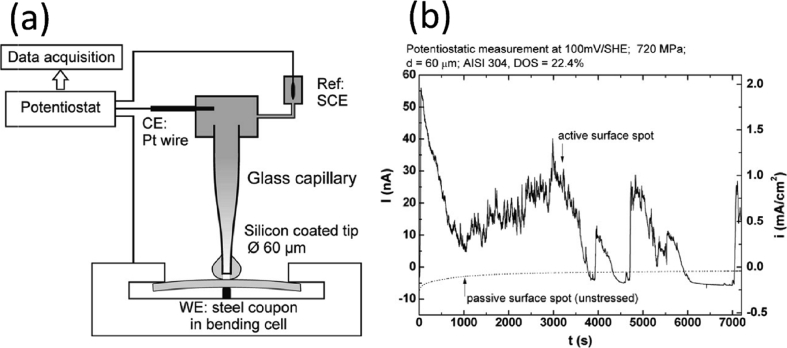
(a) Schematic of the electrochemical micro-capillary technique used by Breimesser et al. [2012]31; (b) results from potentiostatic experiment using the micro-capillary technique with a stressed sensitised 304 stainless steel specimen.